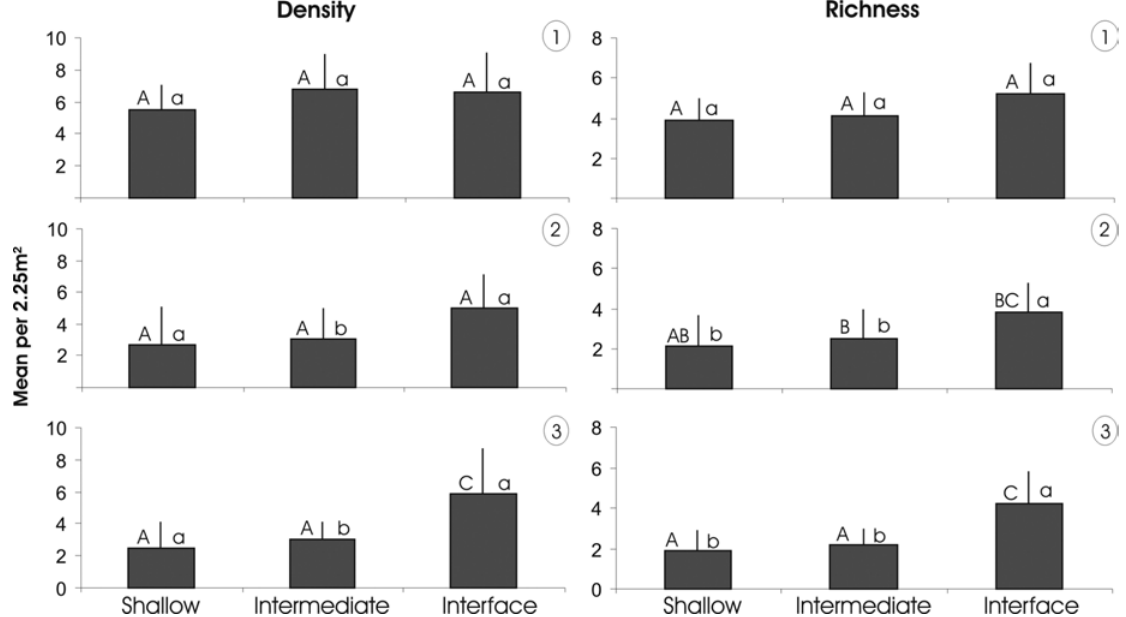
Fig. 3 – Means of density and richness of all species sighted in ID patches at Maramutá reefs. Numbers in circle indicates samples (period); letters above bars indicates homogeneous groups formed by SNK results. Capital letters refers to comparison depth on the same time while minuscule letters refers to comparison depth on different